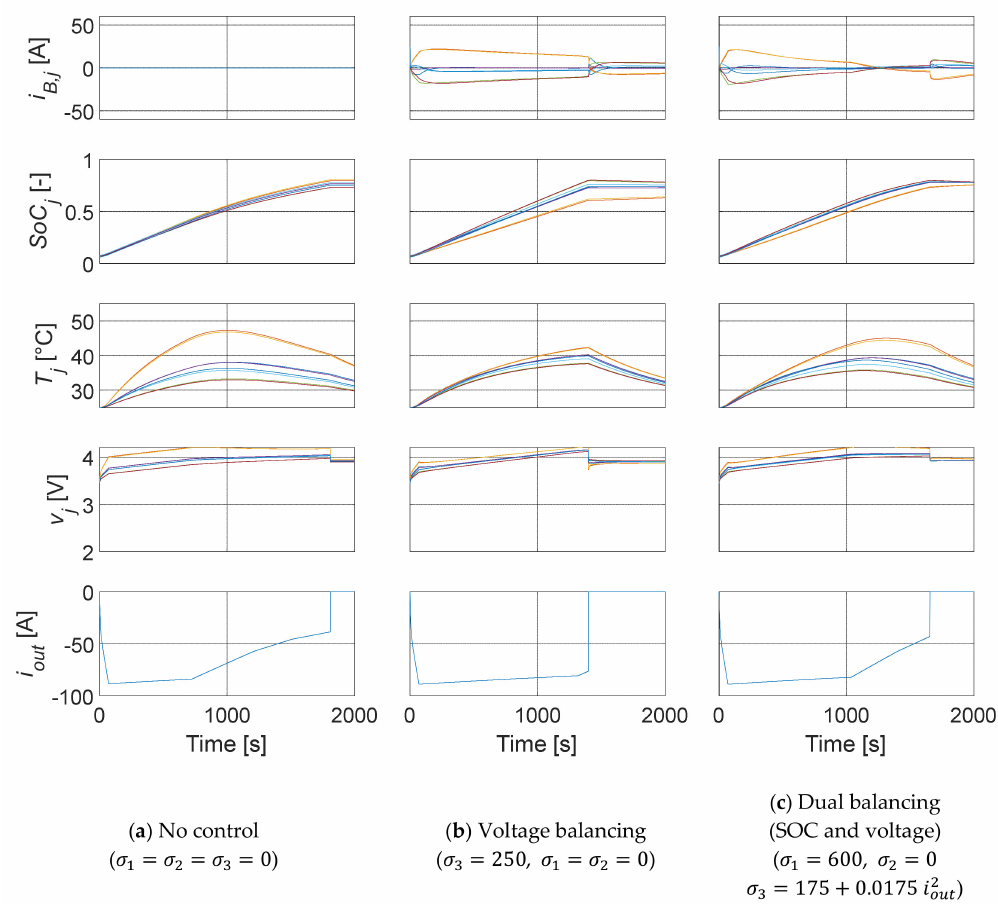
Figure 19. Single and dual controllers results in time. Scenario: fast charging, mixed aging, parallel forced air cooling ( h = 15 W/m 2 K). Each case using its own CP-CV charge power profile optimized to reduce charging